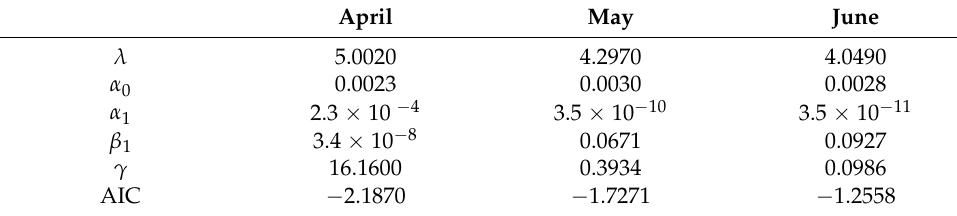
Table 3. Asymmetric HN parameters.